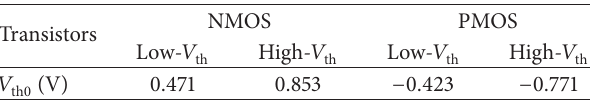
Table 2: The zero bias threshold voltages of transistors.